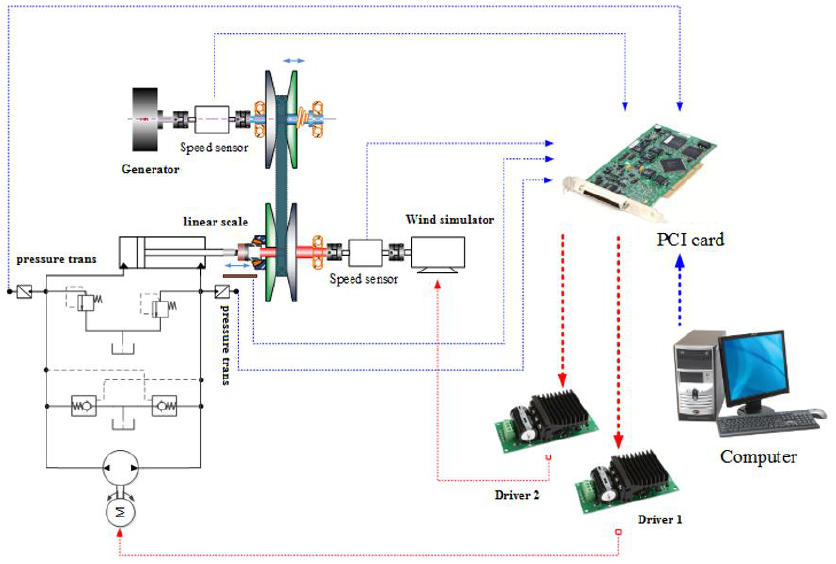
Figure 8. Structure of experiment test rig.